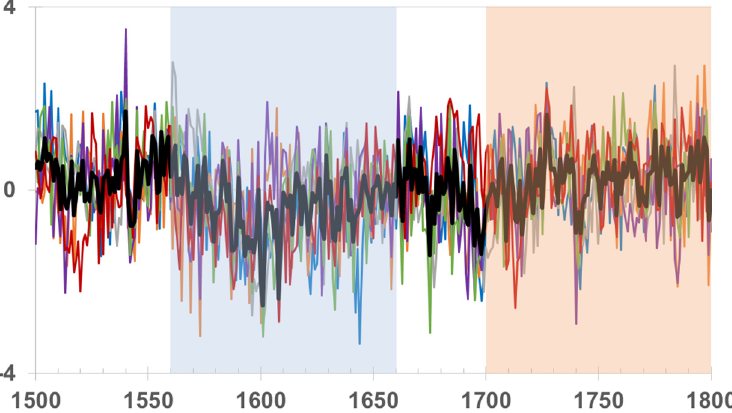
Figure 2. Temperature anomalies in Europe in AD 1500–1800. Note: The orange line is the normalized temperature reconstruction of Luterbacher et al. [37]; the green line is of Luterbacher et al. [38]; the blue line is of Osborn and Briffa [27]; the grey line is of Büntgen et al. [39]; the purple line is of Dobrovolný et al. [40]; and the red line is of Guiot et al. [41]. The bold black line is the arithmetic average of the six normalized temperature reconstructions, which was employed in this study. Blue shade indicates the extreme cooling period during the Little Ice Age (AD 1560–1660), while red shade indicates the warm agricultural recovery period (AD